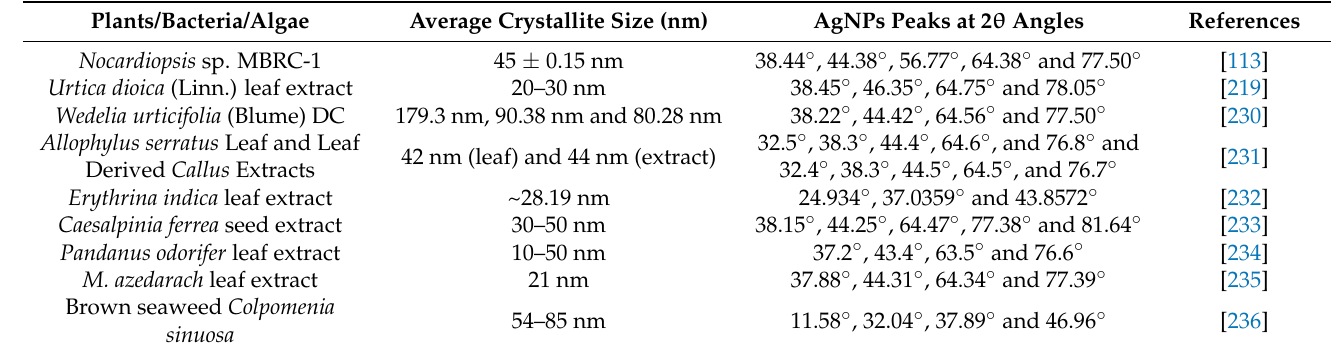
Table 2. Biogenic AgNPs characterization with